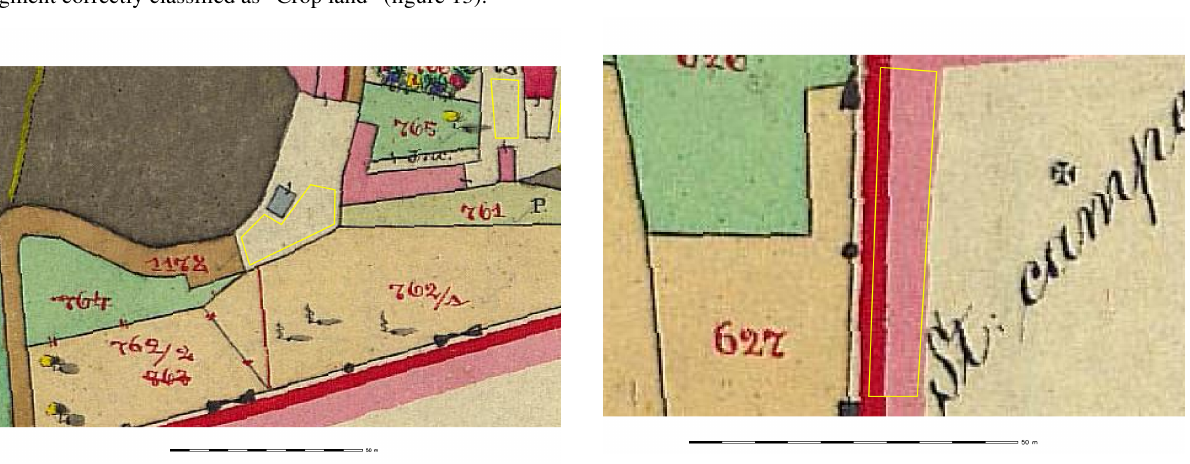
Figure 13. Classified segments for BWWV voter, the garden parcel of figure 12 is misclassified as “Crop land” beacuse it has been merged in a single segment with crop land parcels. The extension of one of the check area for the “Gardens” class is shown in yelllow.